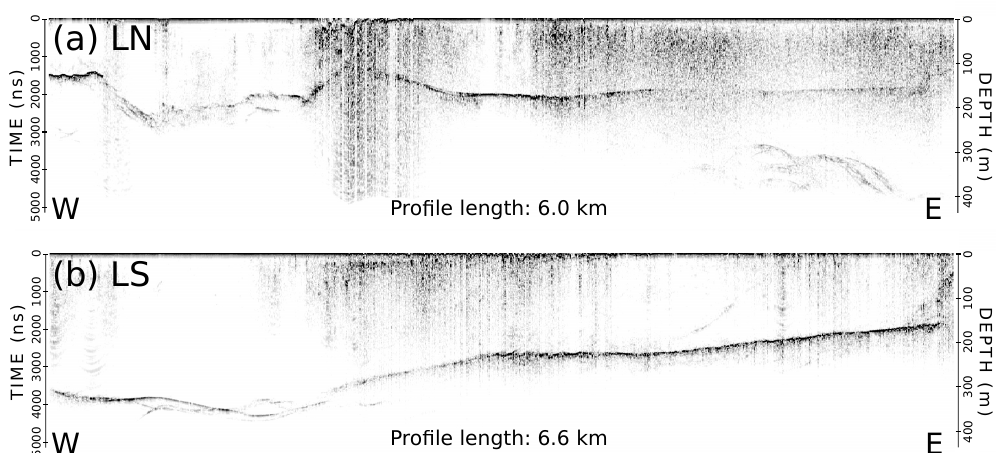
Figure 4. ( a , b ) GPR measurements from 2018 for the profiles LN and LS in Figure